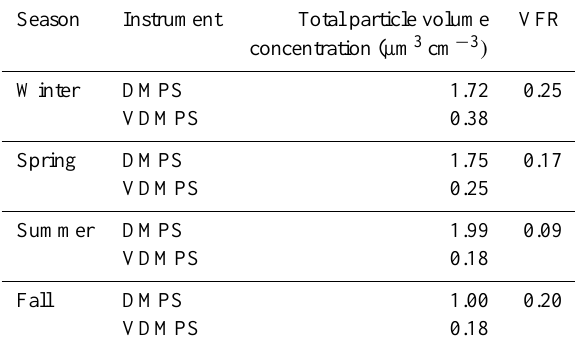
Table 1. Median total particle volume concentrations measured by the DMPS and VDMPS in different seasons as well as the VFR (MFR) of 20–500nm particles at 280 ◦